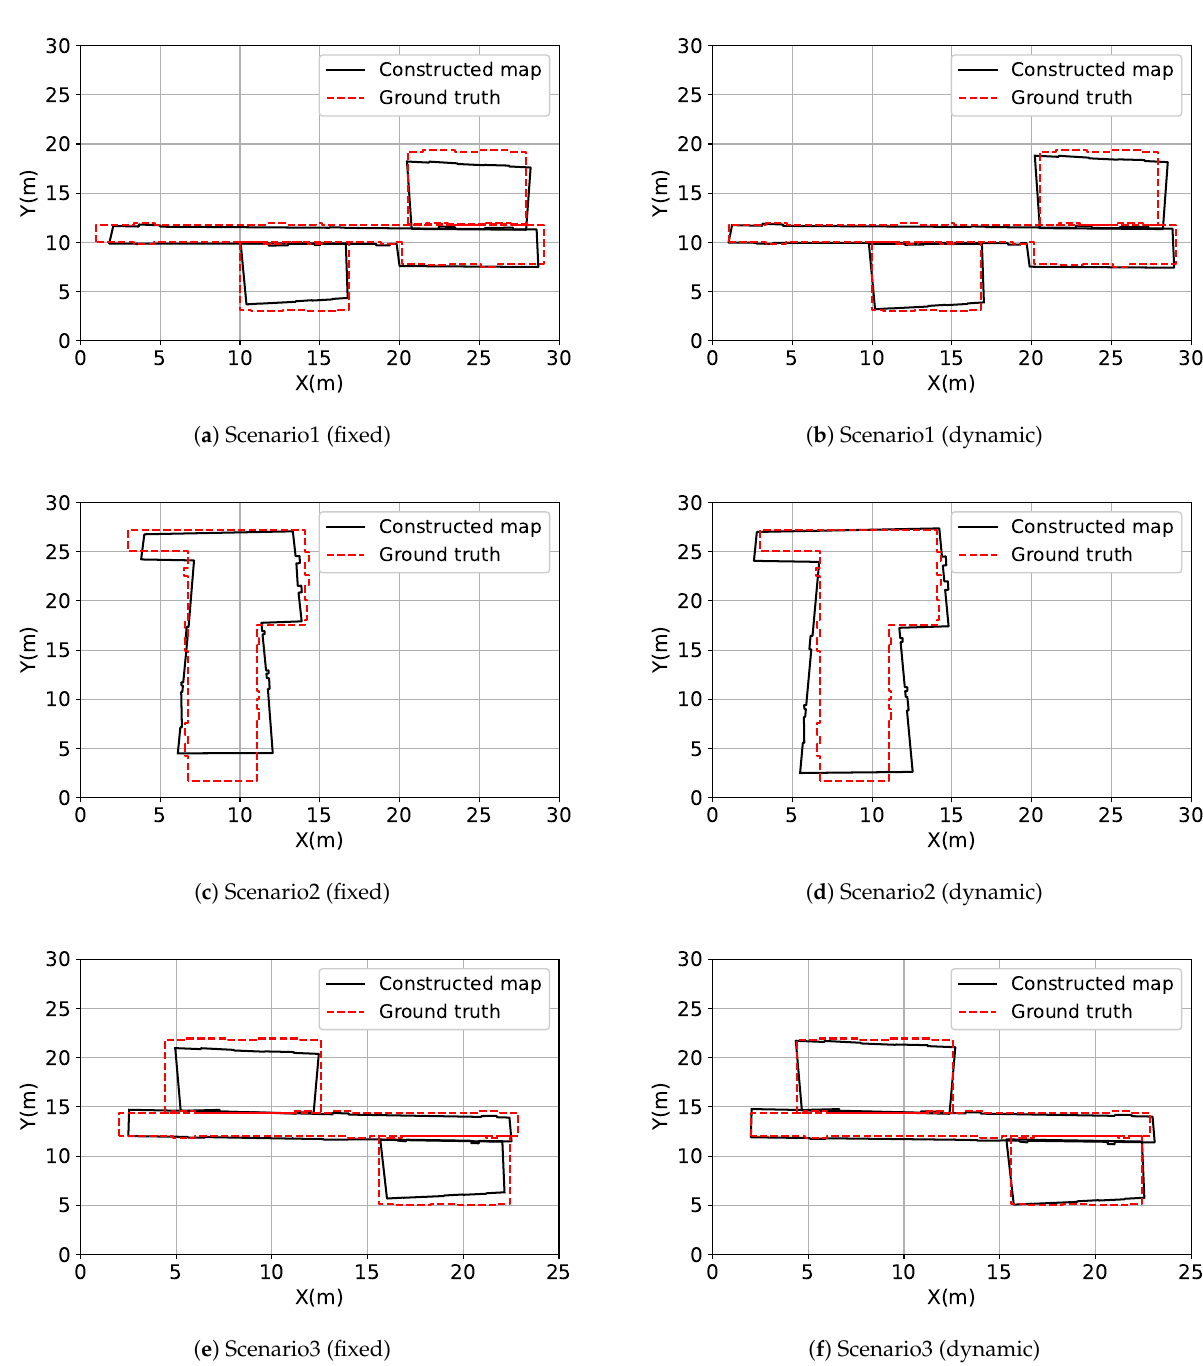
Figure 15. Comparison of indoor floor plan construction effect between dynamic step length and fixed step length of three scenarios in teaching buildings. ( a , c , e ) adopt fixed step length; and ( b , d , f ) adopt dynamic step length. The red dotted line represents the real floor plan, and the black solid line represents the indoor floor plan we